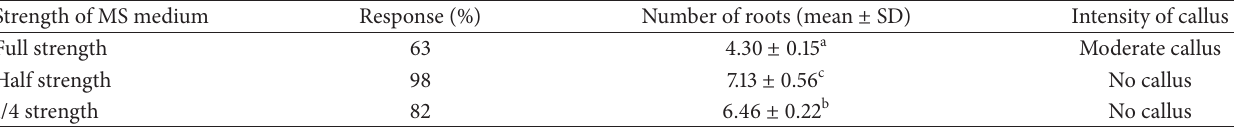
Table 3: Effect of strength of MS medium augmented with 2.0 mgL − 1 IBA on in vitro root initiation from shoots of P. edulis after 4 weeks.